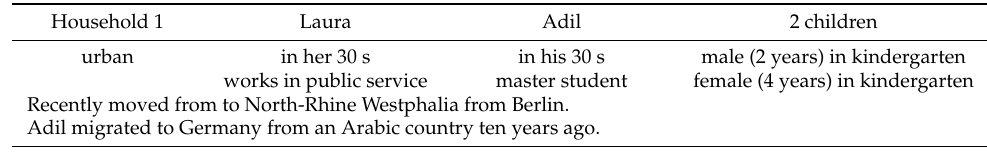
Table 1. Sample of households 1